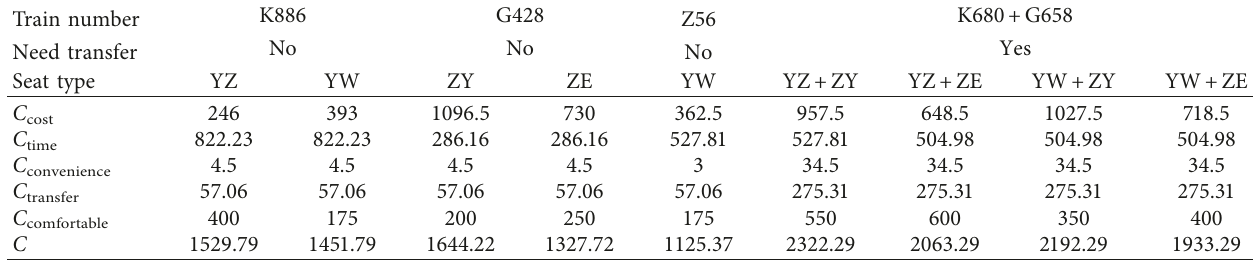
Table 2: Generalised cost calculation table (unit: